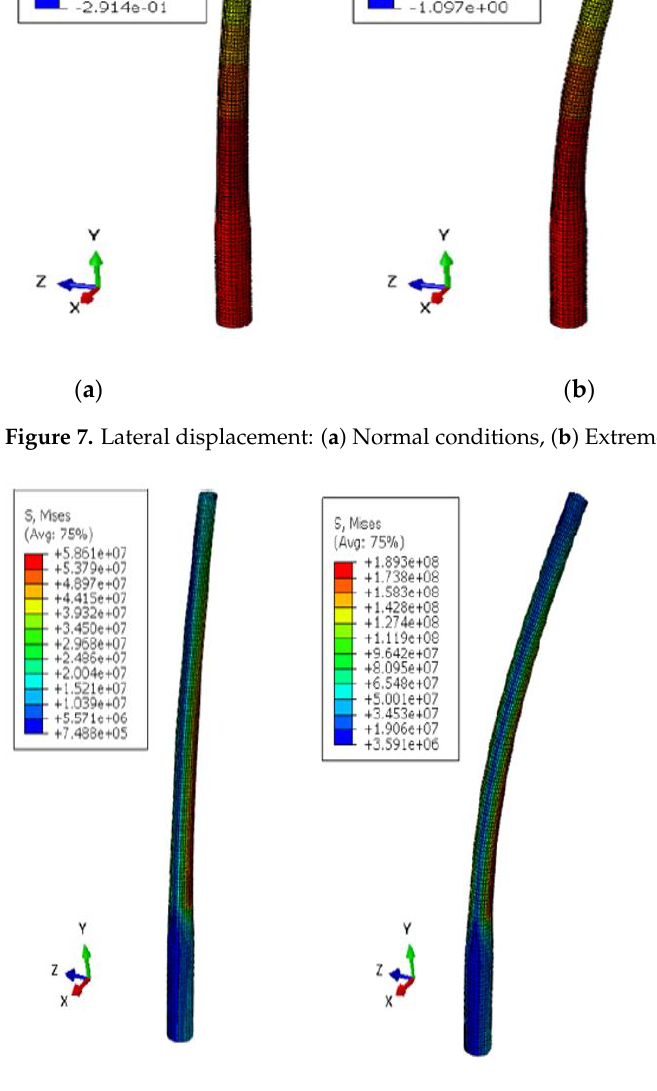
Figure 8. Von Mises stress: ( a ) Normal conditions, ( b ) Extreme sea